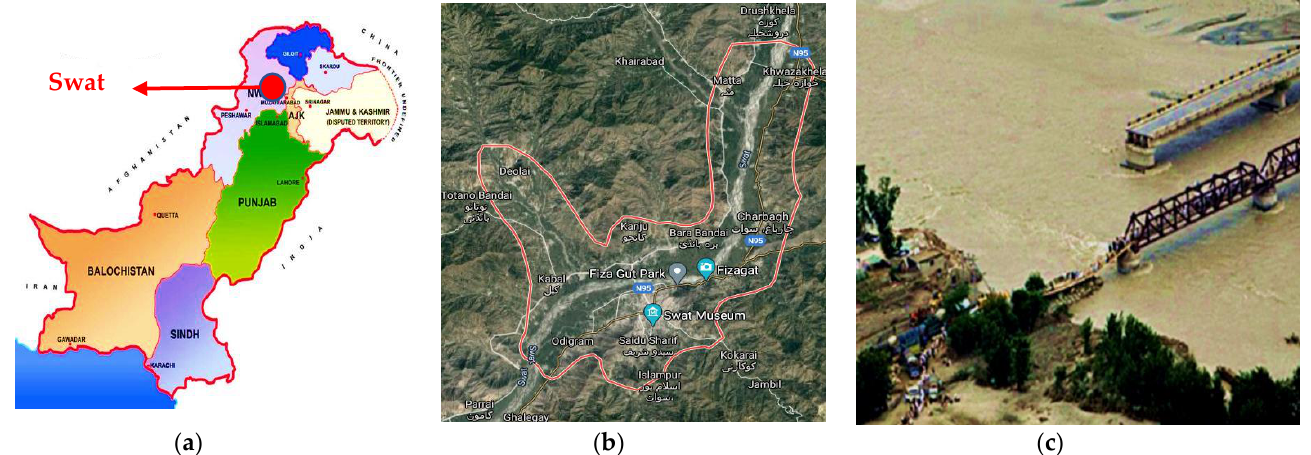
Figure 2. ( a ) Swat District on a map of Pakistan; ( b ) Swat area; ( c ) aerial image of a flood-hit area in Swat.